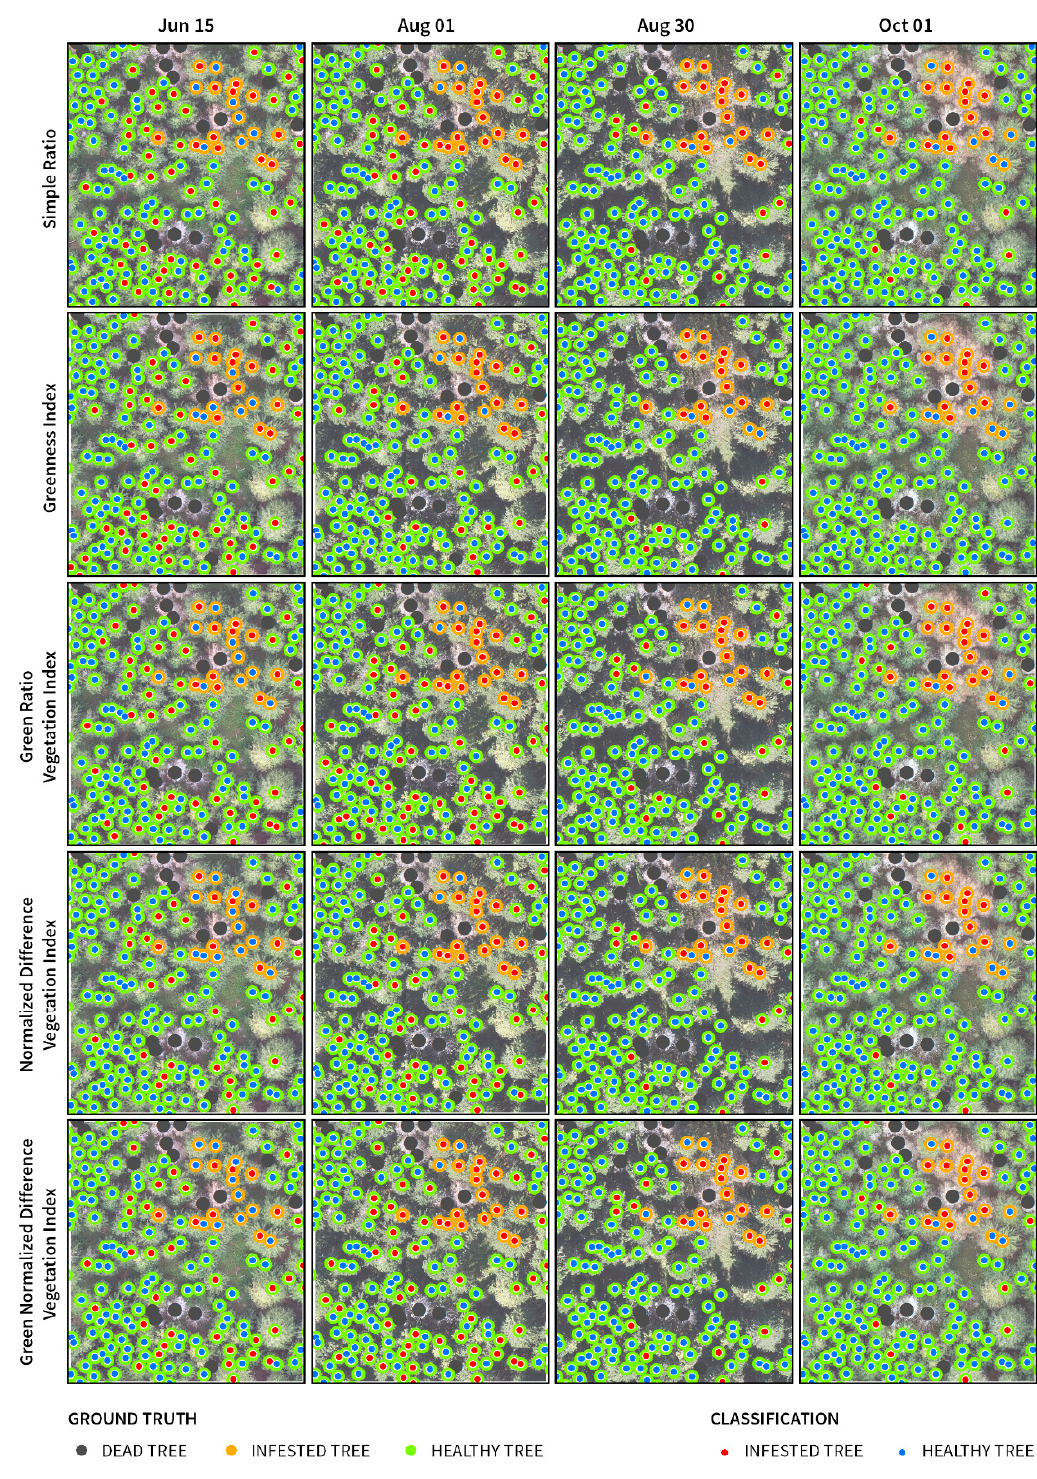
Figure A2. Illustration of the performance of the Maximum Likelihood Classifier (MLC) classification based on the di ff erent vegetation indices in four unmanned aerial vehicle (UAV) sensing periods. The red dots in the figure represent infested trees in di ff erent stages of the bark beetle attack, blue dots represent healthy trees. The trees without dots are dead trees infested in previous years. The illustration represents only a small subset of the study